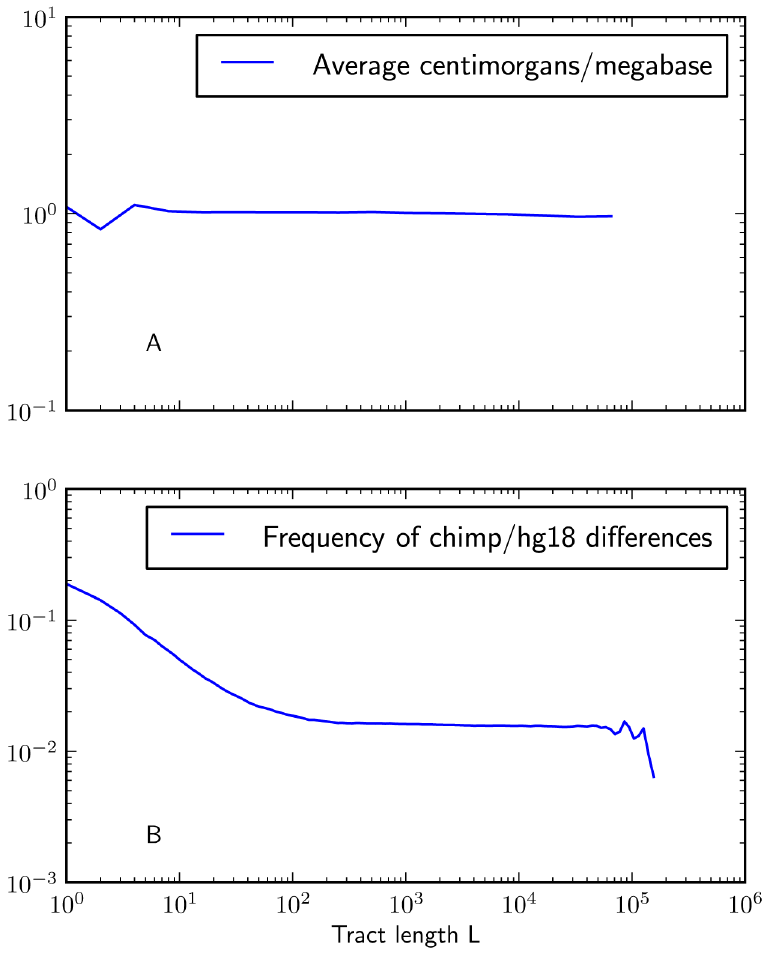
Figure 6. Mutation and recombination rates within L -base IBS tracts. Figure 6A shows that there is no length class of IBS tracts with a significantly higher or lower mutation rate than the genome-wide average (recombination rates are taken from the deCODE genetic map [53]). In contrast, Figure 6B shows that IBS tracts shorter than 100 base pairs occur in regions with higher rates of human-chimp differences than the genomewide average. These plots were made using IBS tracts shared between Europeans and Africans, but the results are similar for IBS sharing within each of the populations. Table 2. We estimate that the European-African divergence occurred 55 kya and that gene flow continued until 13 kya. About 5.8% of European genetic material is derived from a ghost population that diverged 420 kya from the ancestors of modern humans. The out-of-Africa bottleneck period, where the European effective population size is only 1,530, lasts until 5.9 kya. Given this history and parameter estimates, we simulated 12 gigabases each of European and African sequence data under the full coalescent with recombination, obtaining an IBS tract length distribution that is very close to the one observed in the trios (see Figure 8).